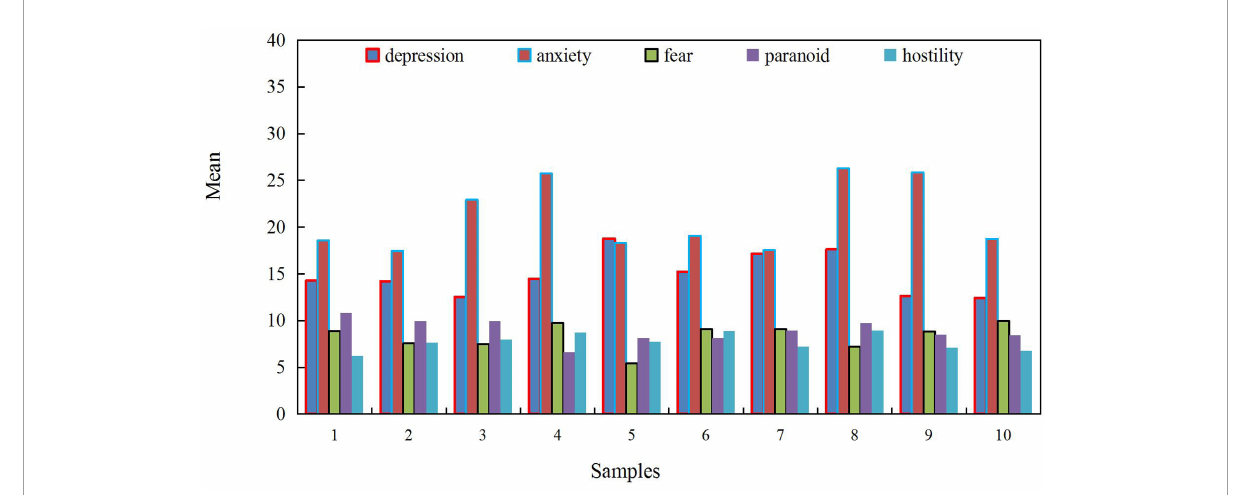
FIGURE8 The influence of anxiety level of college students after the course of mental health